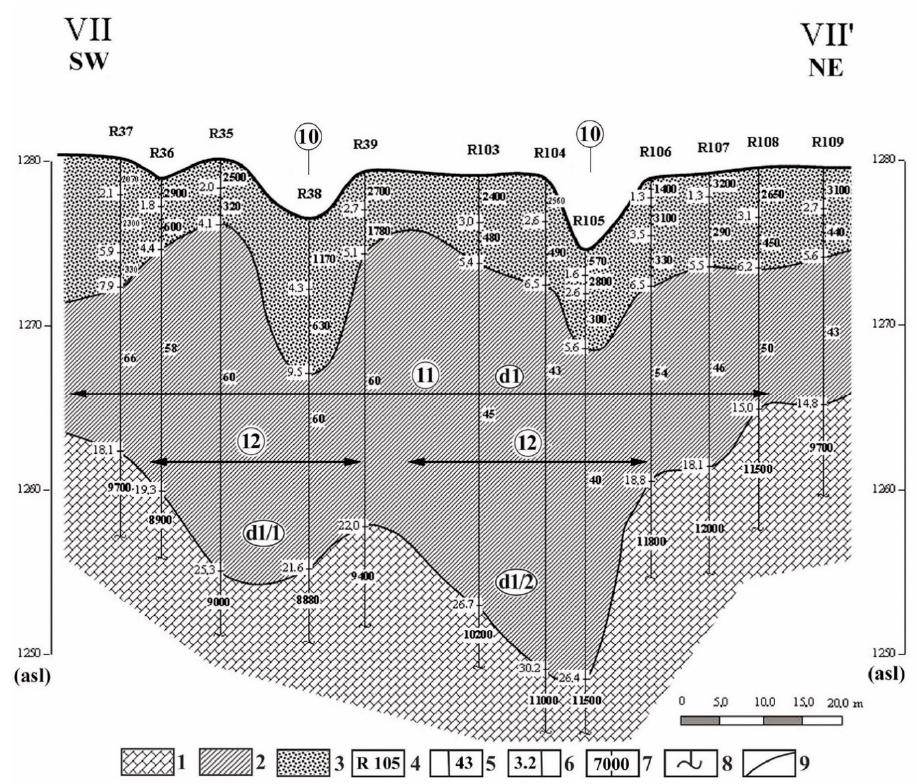
Figure 7. Geoelectric–geological profile (marked I–I’) from the area of the main partial doline marked P1 (R ă chite). Legend: (1) limestone, (2) clayey silt, (3) mixed rock debris (sand, sandstone and limestone debris), (4) site and identification code of the VES measurement, (5) geoelectric resistance of the series ( Ω m), (6) base depth of the geoelectric series (m), (7) geoelectric resistance of the bedrock ( Ω m), (8) approximate depth of the penetration of the VES measurement, (9) geoelectric series boundary, (10) depression of the bedrock with the identification code and (11) subsidence doline.